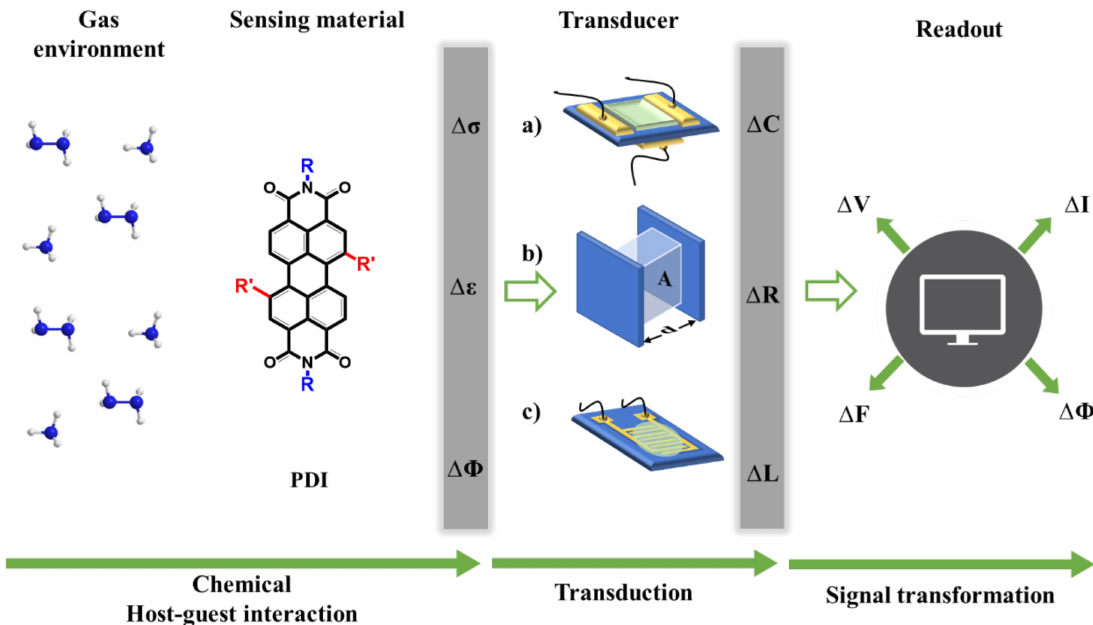
Figure 2. Schematic diagram illustrating the major components required to evaluate an electrical mode gas-sensing mechanism. The transducers are ( a ) FETs, ( b ) capacitors and ( c ) chemiresistors. Analytes interact with the sensing material changes some of its physical properties such as conductivity (s), work function (j), and permittivity (e). The transducer converts one of these physical quantities into the variation of its electric parameters such as capacitance, C , and resistance, R . Finally, the circuit to which the sensor is connected gives rise to the sensing electrical signal that can be in either current ( I ) or voltage ( V ), and each can be measured in frequency ( F ) and phase ( Φ )